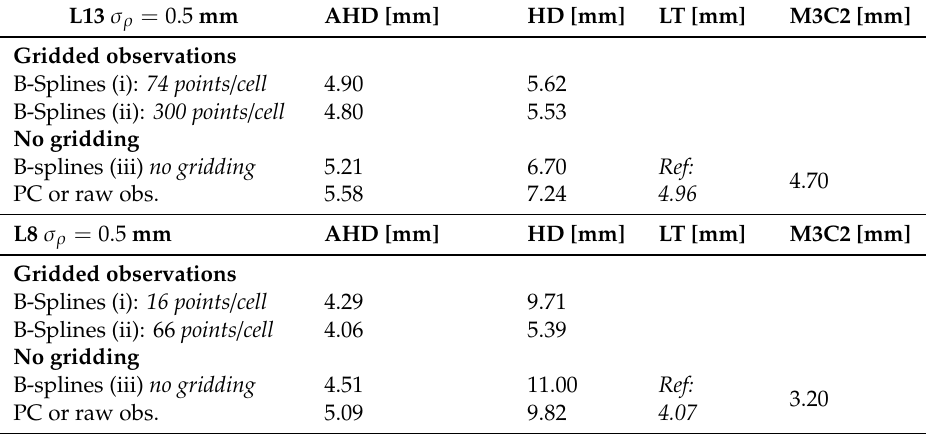
Table 4. The HD and AHD for the two points L8 and L13 under consideration. Case (i) and (ii) correspond to a B-spline approximation with a reduction of the PC via gridding. Case (iii) B-spline fitting without gridding using the whole PC. For all approximations we took no mathematical approximation was performed. The values are compared with the Euclidian distance obtained from the LT observations between the two epochs as well as the usual M3C2